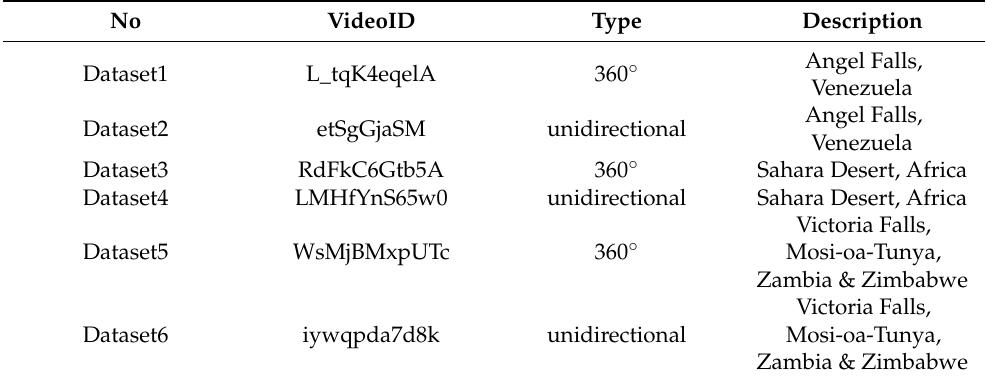
Table 1. List of six videos for case